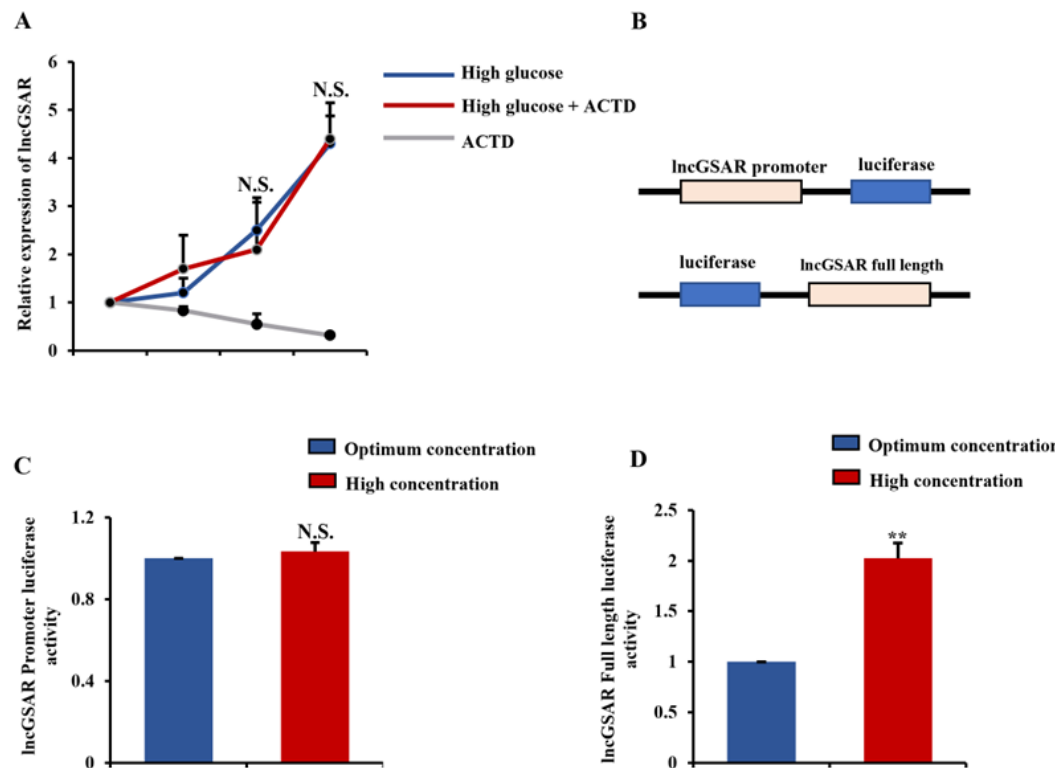
Figure 2. LncGSAR is transactivated upon glucose stimulation. ( A ) The GCs were treated with actinomycin D to explore the effect of glucose on the expression of lncGSAR. ( B ) Dual-luciferase reporter assay was conducted of lncGSAR promoter sequence and full-length sequence. ( C ) Dual-luciferase reporter for the lncGSAR promoter. ( D ) Detection of lncGSAR full-length luciferase activity. Values represent means ± SEM for three individuals. ** p < 0.01. N.S., not significant.